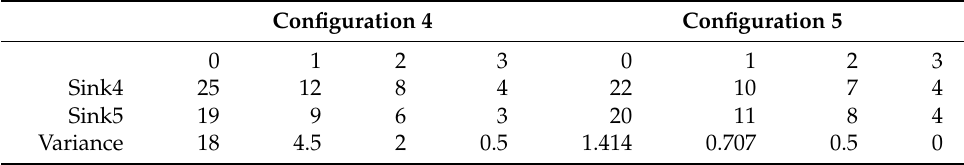
Table 7. Node migration: Node interference